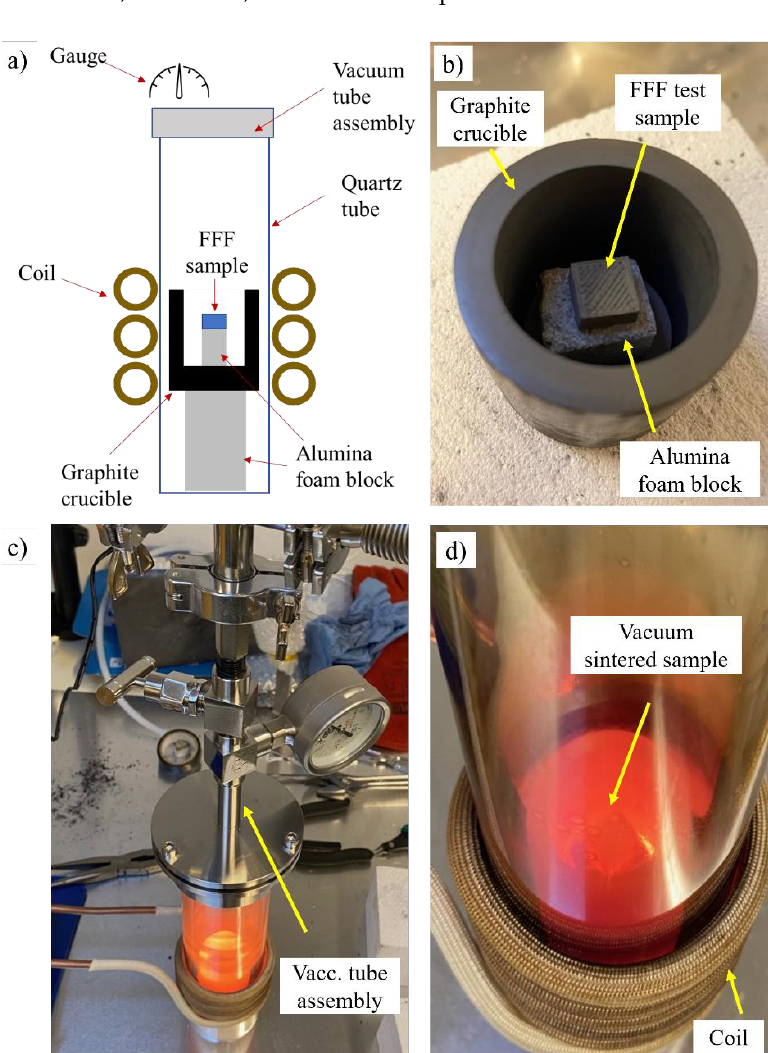
(Figure 6d). The vacuum sintering trials were conducted for hold times of 10 s, 30 s, 1 min, and 6 min, after which the specimens were left to cool to room temperature.